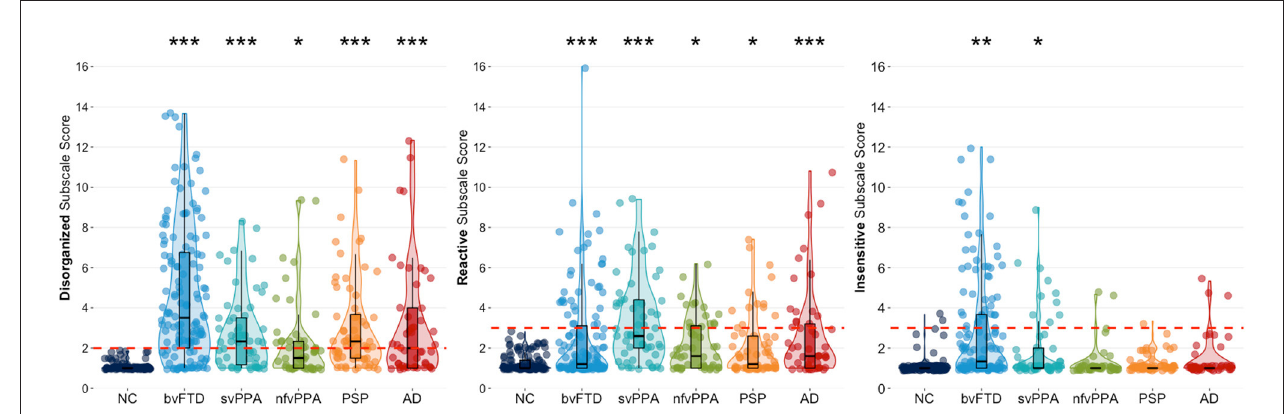
FIGURE 1 | Violin boxplots of each cluster’s mean severity score classified by diagnostic group. Dunnett-Hsu post-hoc tests were used to compare least-square mean subscale scores between each patient group and the NC group. The red dotted lines represent the proposed scoring threshold for each subscale score. NC, healthy older controls; bvFTD, behavioral variant frontotemporal dementia; svPPA, semantic variant primary progressive aphasia; nfvPPA, non-fluent variant primary progressive aphasia; PSP, progressive supranuclear palsy; AD, Alzheimer’s disease. *Patient group differs from NC at p < 0.05; **Patient group differs from NC at p < 0.001; ***Patient group differs from NC at p < 0.0001.